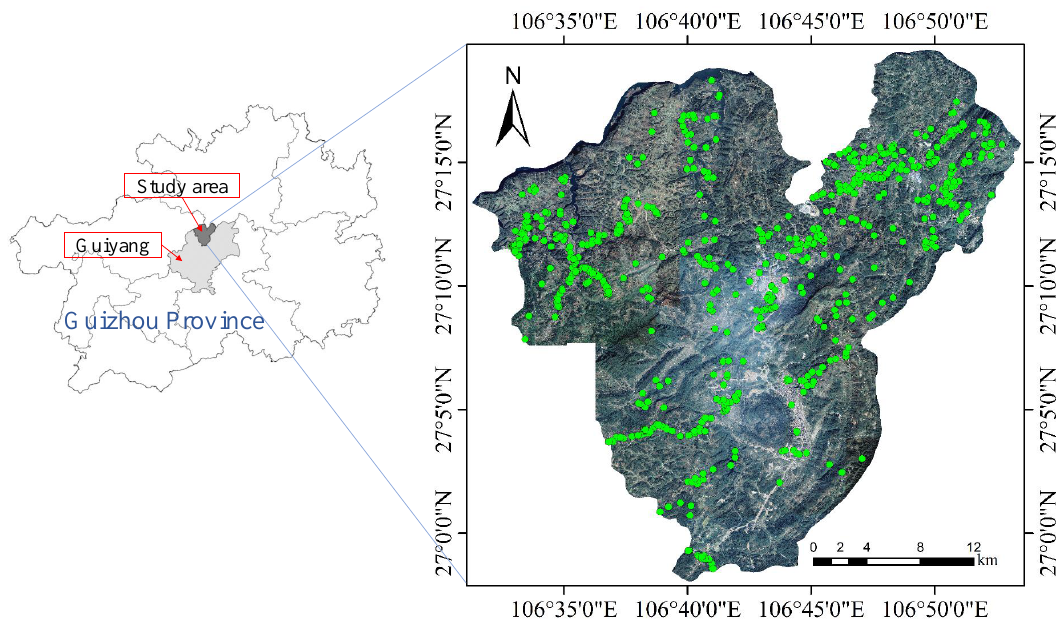
Figure 1. The location of the study area: the green dot represents the location of the sampling point, and the background is a Google satellite image composite of three periods (2 November 2018, 2 February 2019, 7 April